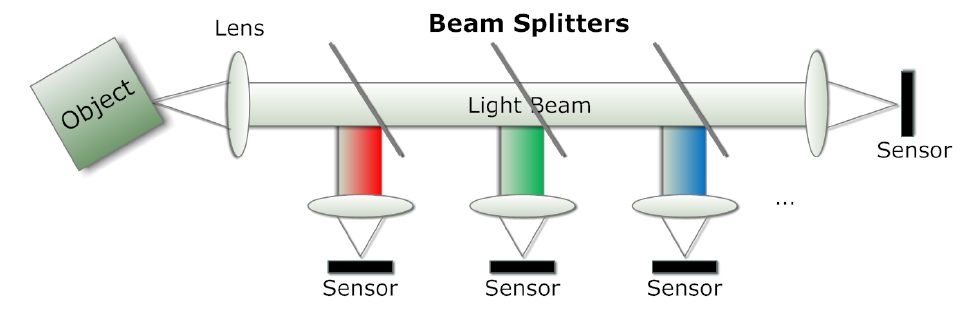
The design of a multi-spectral system. Three beam splitters with different wavelength ranges and three highly reflective